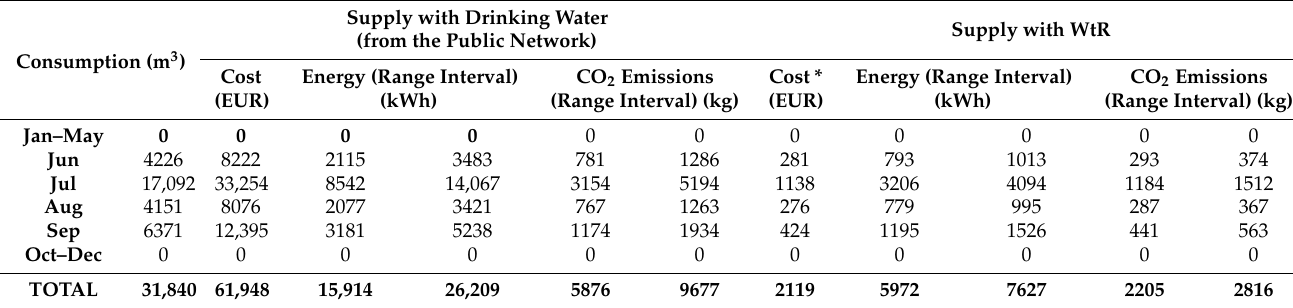
Table 3. Scenario 1: Supply with drinking water and WtR to the golf course.